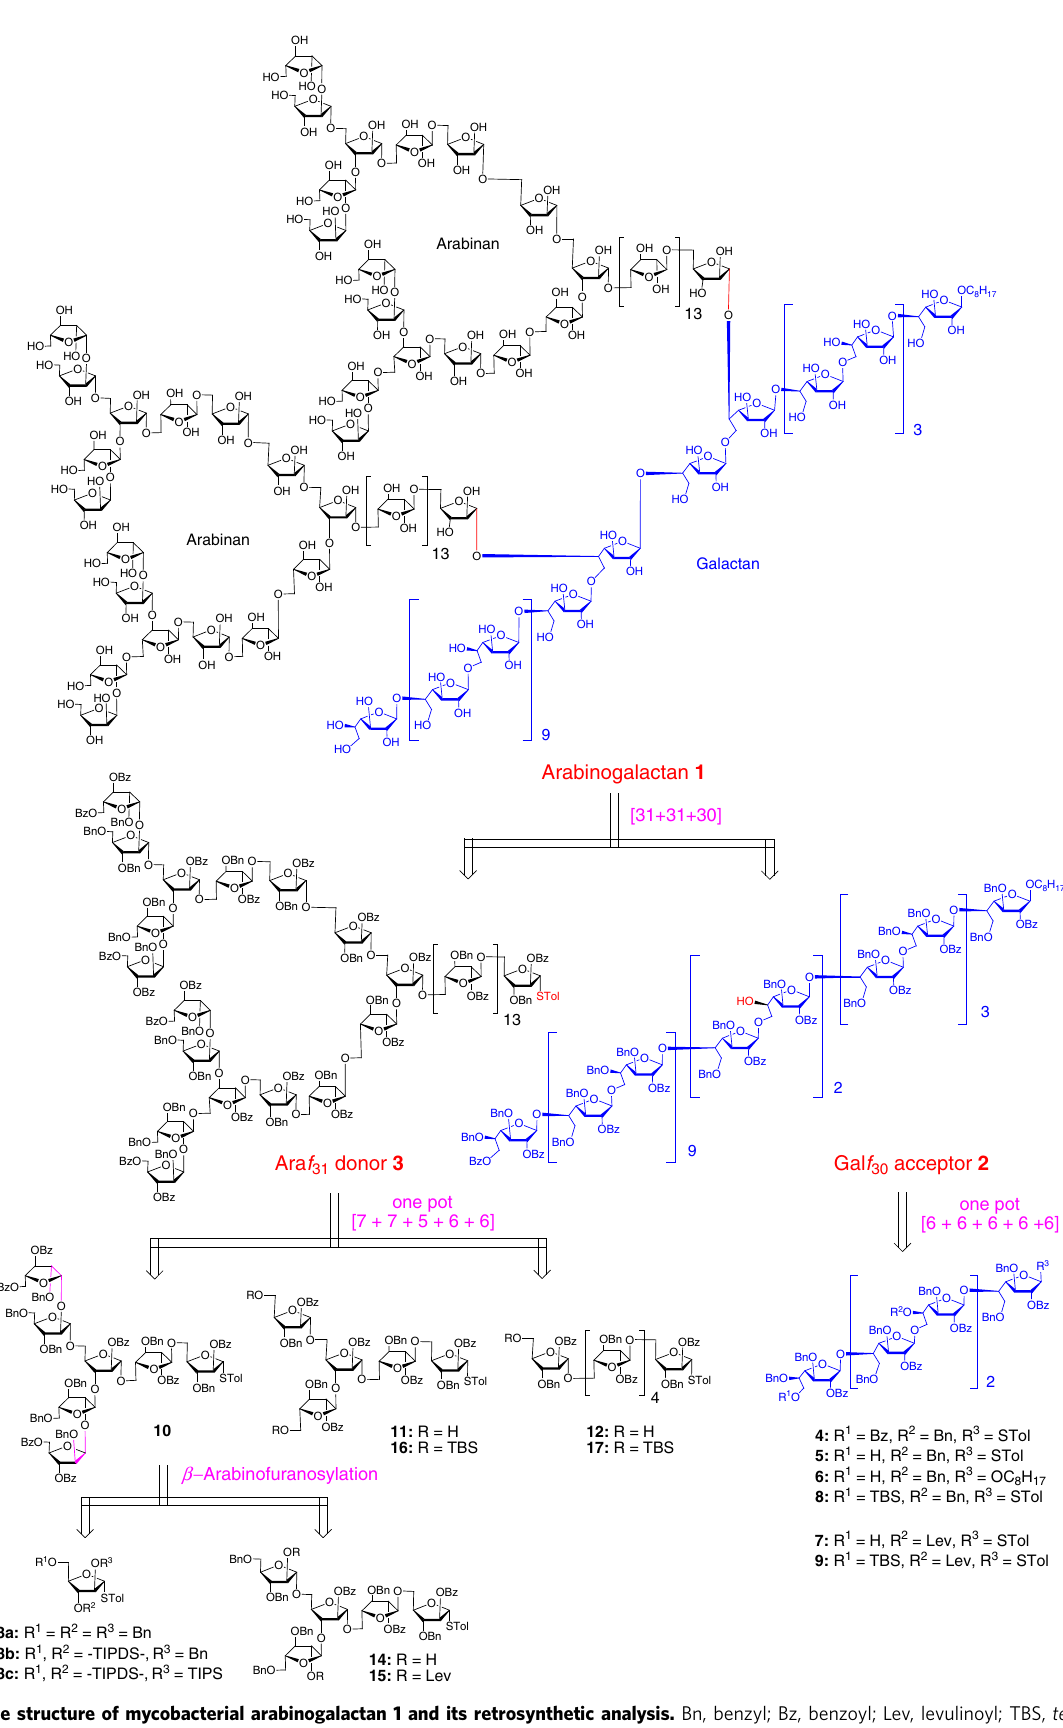
13a: R 1 = R 2 = R 3 = Bn 13b: R 1 , R 2 = -TIPDS-,R 3 = Bn 13c: R 1 , R 2 = -TIPDS-,R 3 = TIPS Figure 1 | The structure of mycobacterial arabinogalactan 1 and its retrosynthetic analysis. Bn, benzyl; Bz, benzoyl; Lev, levulinoyl; TBS, tert -butyl- dimethylsilyl; TIPDS, tetraisopropyldisiloxanylidene; TIPS, triisopropylsilyl; Tol, p